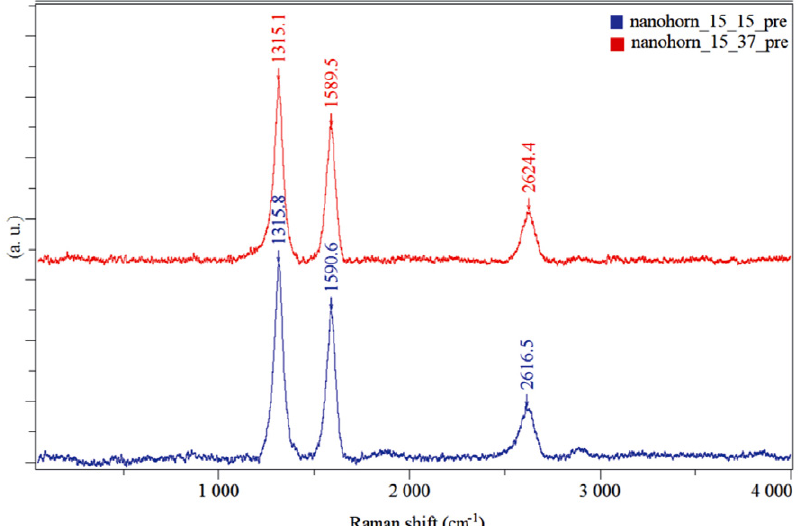
Figure 4. Raman spectra for oxidized carbon nanohorns.